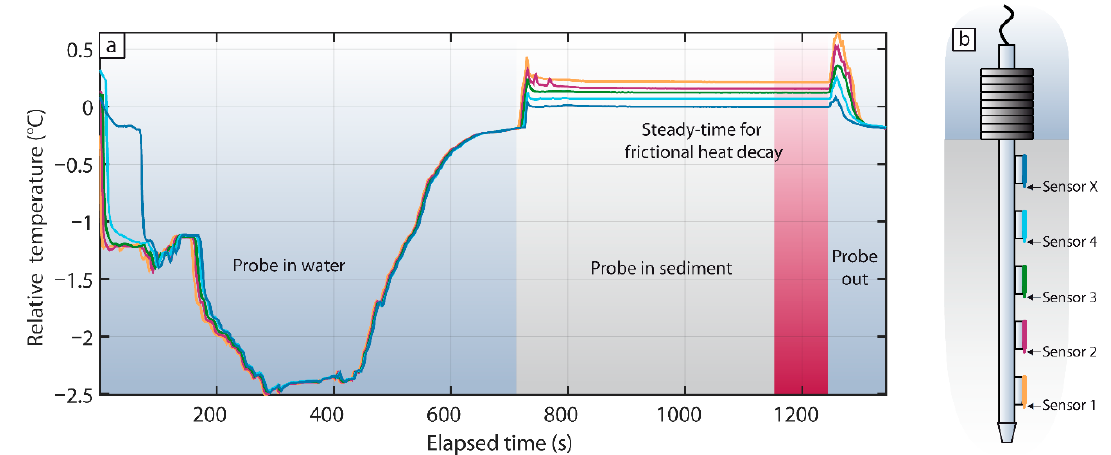
Figure 2. ( a ) The different deployment stages are highlighted for a data example. The probe is lowered through the water column; frictional heat is created when the instrument enters the sediment. The steady-time allows for frictional heat decay. During the sta- bilization phase, temperature signal variations become relatively small and only occur near the sensor resolution range (±0.001 K). ( b ) Schematic drawing of the probe and sensor geometry. The sediment sensors are equidistantly mounted along the metal rod. The weight at the upper end enforces sediment penetration. A water sensor is fixed above the weight. Please note for simplification of this figure, they appear to be in line, whereas they were distributed around the rod to minimize the disturbance of the sediment. Measurements were conducted at 17 sites at the western Antarctic Peninsula Shelf, the South Orkney Shelf, and in the Powell Basin.